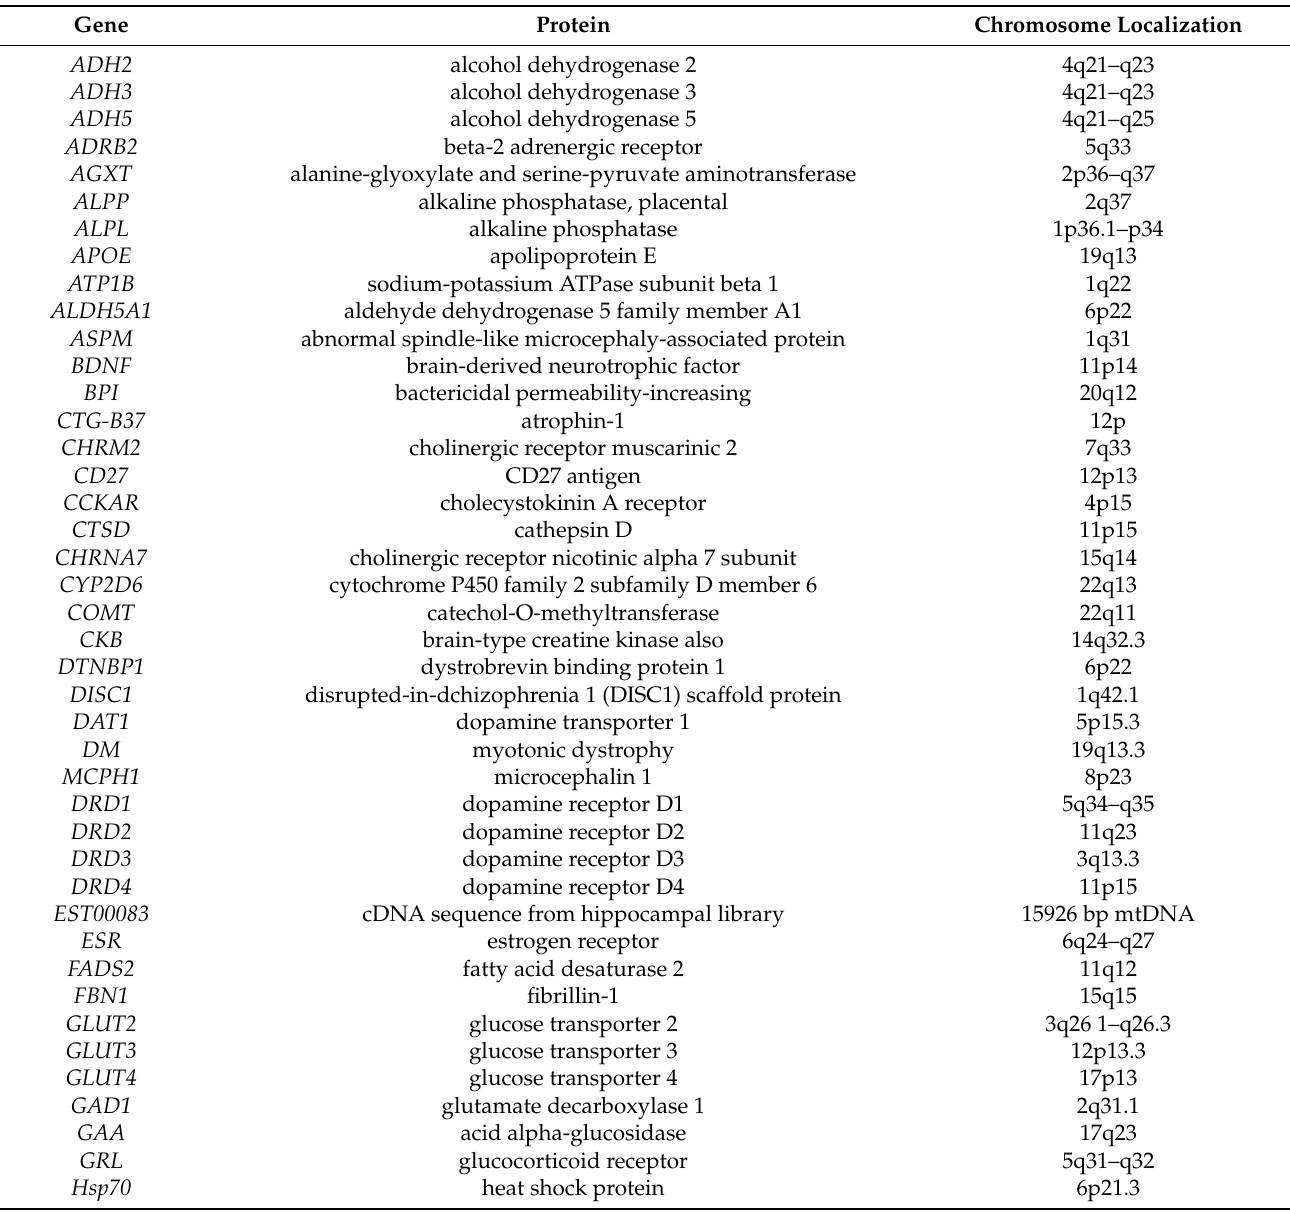
Table 1. List of genes associated with human intelligence